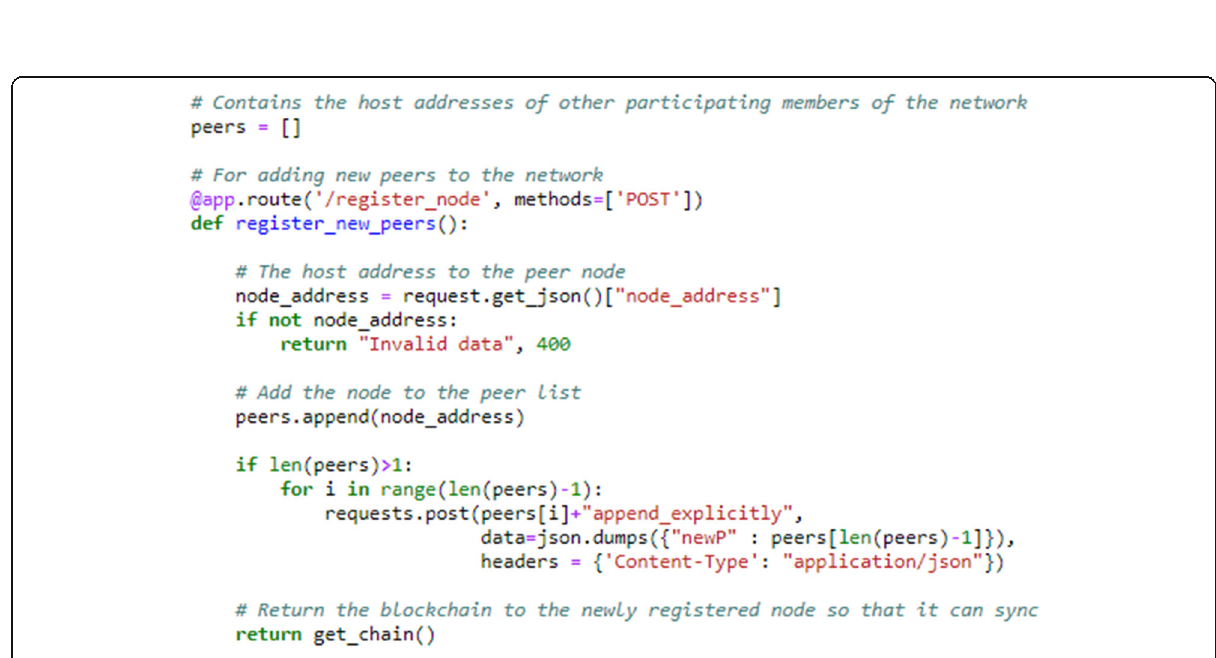
Fig. 9 Code for registering a new node to the